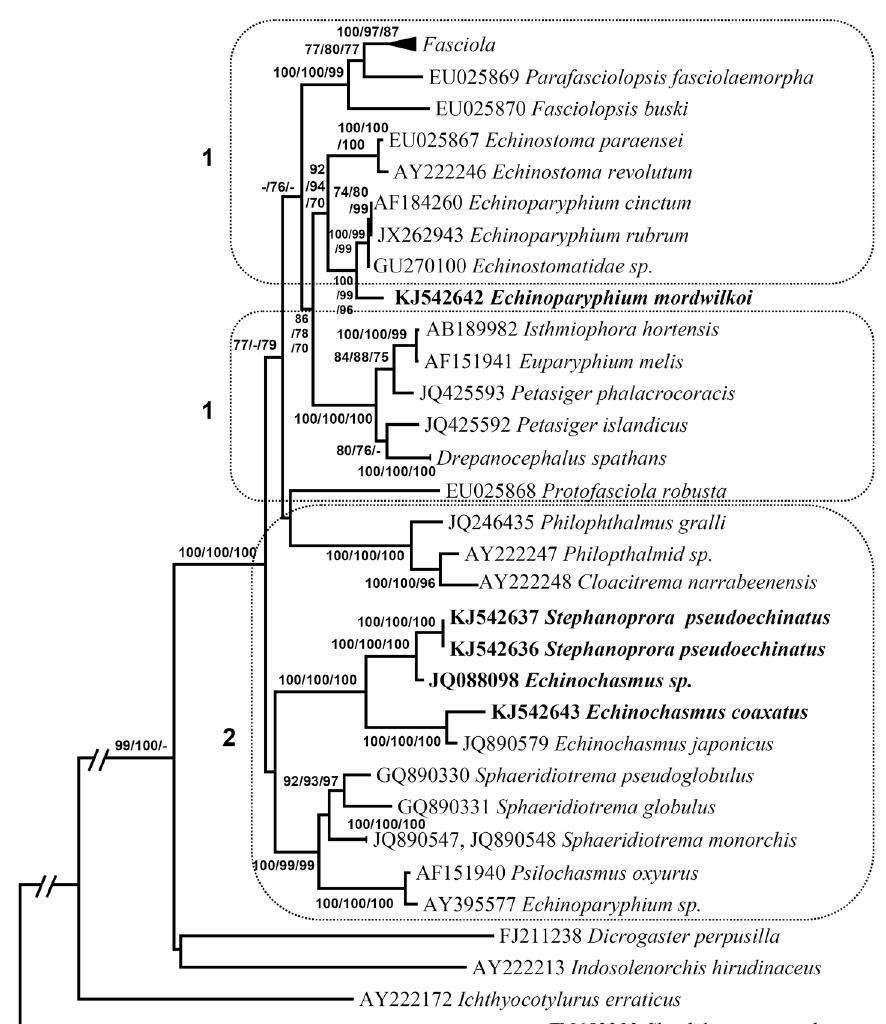
Figure 3. Phylogenetic 28S tree. Maximum likelihood phylogenetic tree based on analysis of ribosomal 28S gene DNA partial sequences. Bootstrap percentages refer to maximum likelihood / neighbor-joing / maximum parsimony analysis. Only bootstrap values above 70% are shown. GenBank accession numbers are indicated before species names. Names of the target species are in bold.Compressed clade Fasciola com- prised sequences under GenBank accession numbers AY222244, EU025871, EU025872, HM004190). Dotted rectangles 1 indicate digeneans whose life cycles include Lymnaeoidea as first intermediate host; dotted rectangle 2 indicates digeneans whose life cycles include prosobranch snails as first intermediate